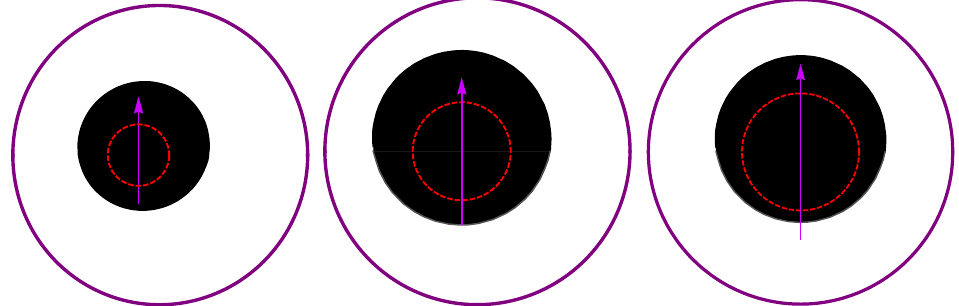
Figure 10. The dark silhouettes of the southern hemisphere of the event horizon (black region) in the case of supermassive black hole M87* ( θ 0 = 17 ◦ ), projected inside an outline of the classical black hole shadow (closed purple curves) in the cases of black hole spin, respectively, a = 0.9982 ( left ), 0.65 ( middle ) and 0 ( right ).